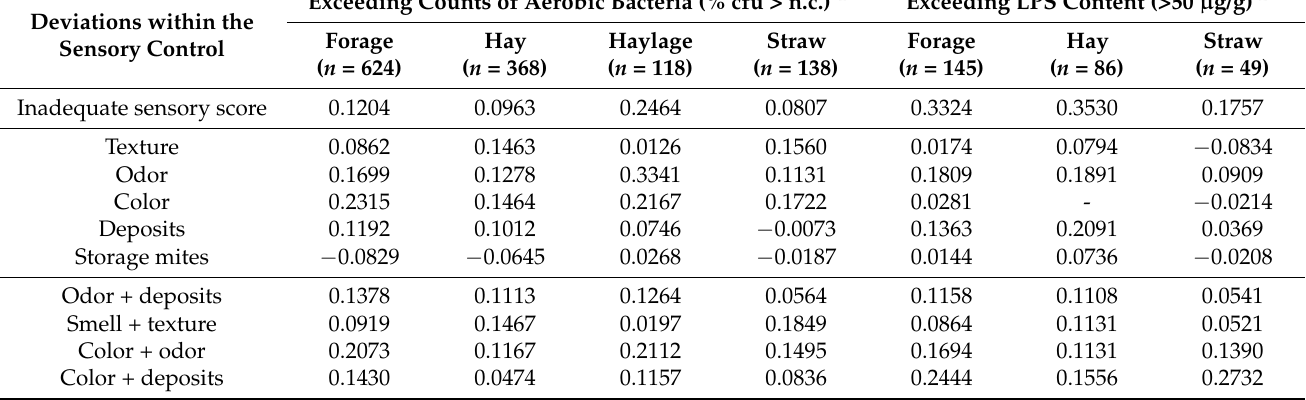
Table 7. Agreement of deviations in sensory control (single parameters and combinations of param- eters) and exceeding counts of aerobic bacteria, as well as exceeding LPS contents (calculation of Cohen’s Kappa) in different forage